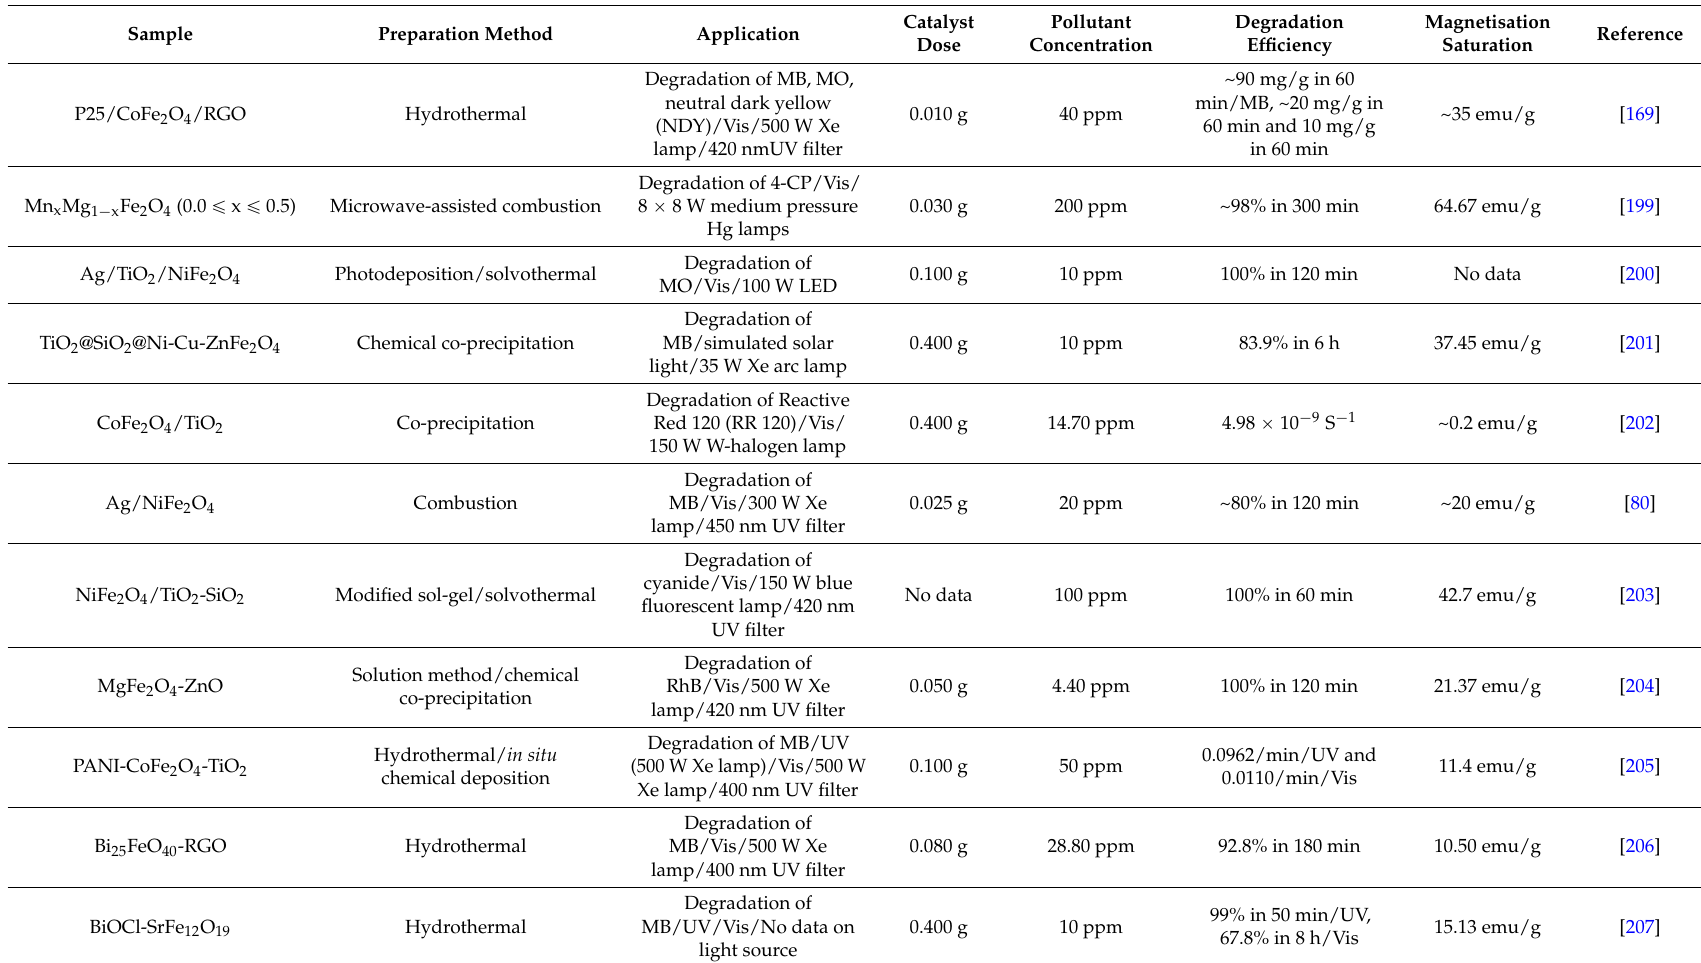
Table 3. Summary of the photocatalytic properties of ferrite-based